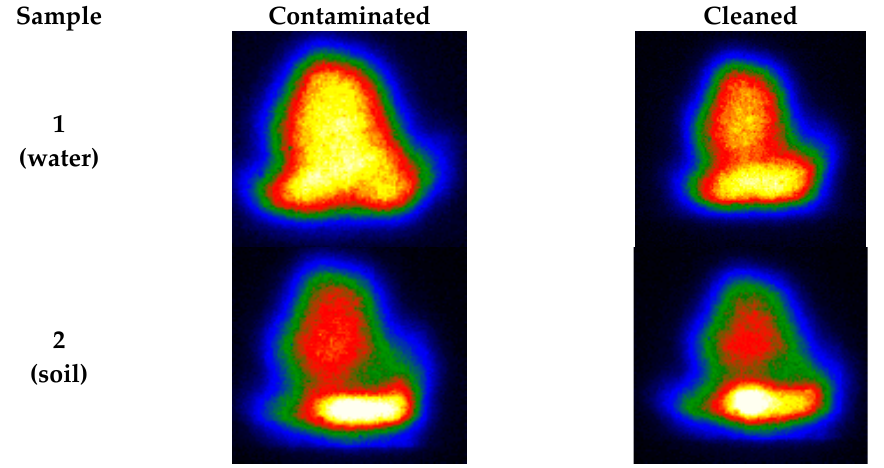
Figure 4. Single element spectral line analysis. ( a ) Contaminated with water, ( b ) laser-cleaned, ( c ) contaminated with soil, and ( d ) laser-cleaned. (Mean values of the 20th to 40th excitation spectra).